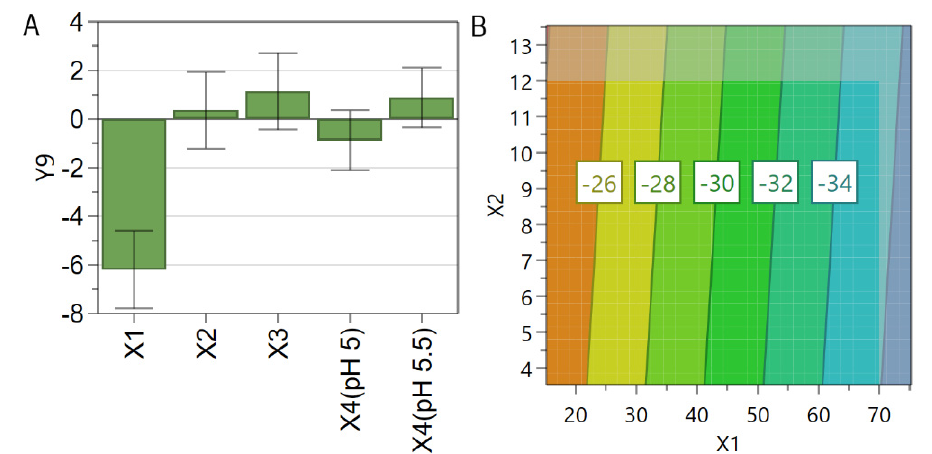
Figure 6. The coefficient plot ( A ) for zeta potential response showing the significance of formulation factors in respect to this response. The response contour plot ( B ) for zeta potential response showing the variance of experimental results in respect to PL concentration (X1) and SIM concentration (X2). X1: PL concentration (mM); X2: SIM concentration (mM); X3: DOX concentration (mM); X4: the pH of the AS solution; Y9: zeta potential (mV).